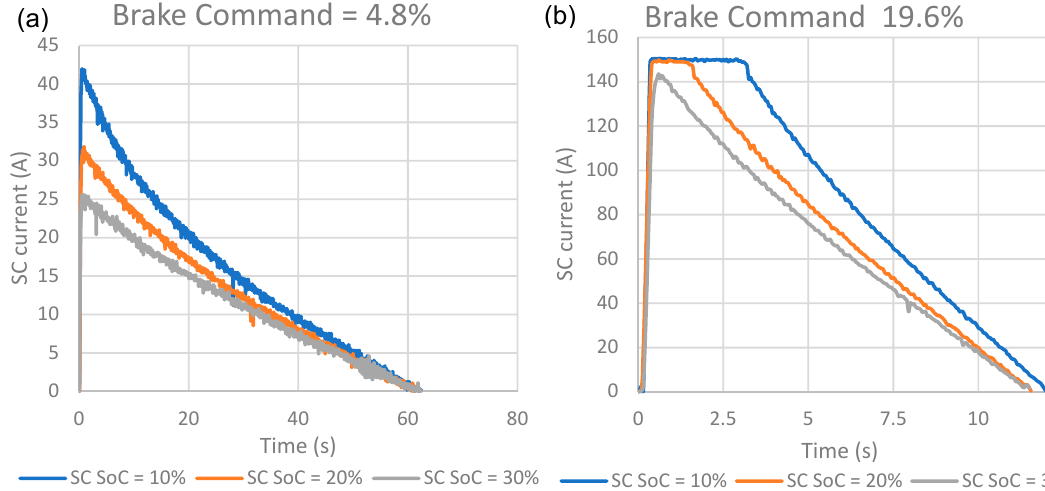
Figure 6. SC current for ( a ) 4.8% brake command and ( b ) 19.6% brake command.